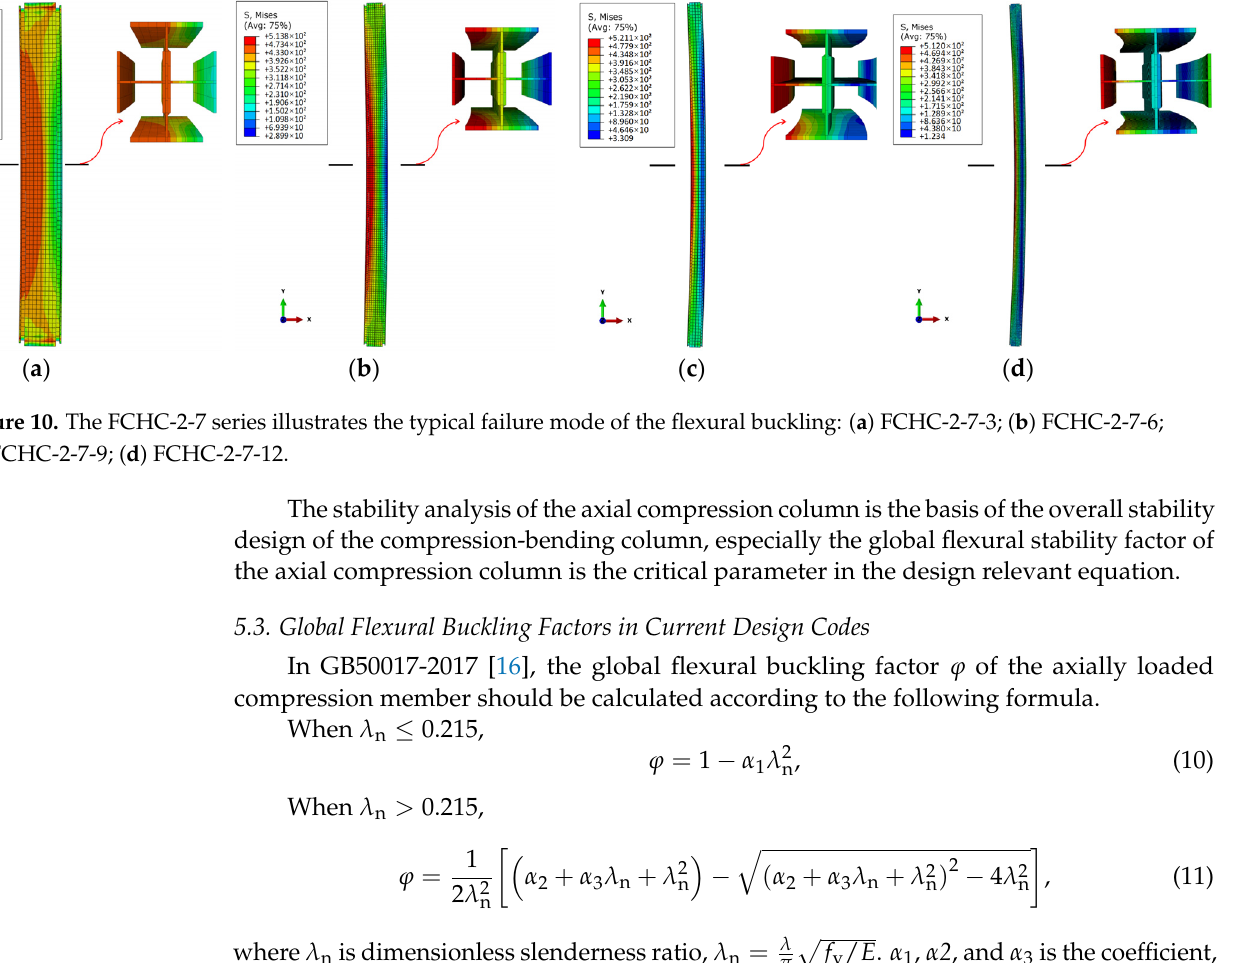
FCHC-2-3-6; ( c ) FCHC-2-3-9; ( d ) FCHC-2-3-12.